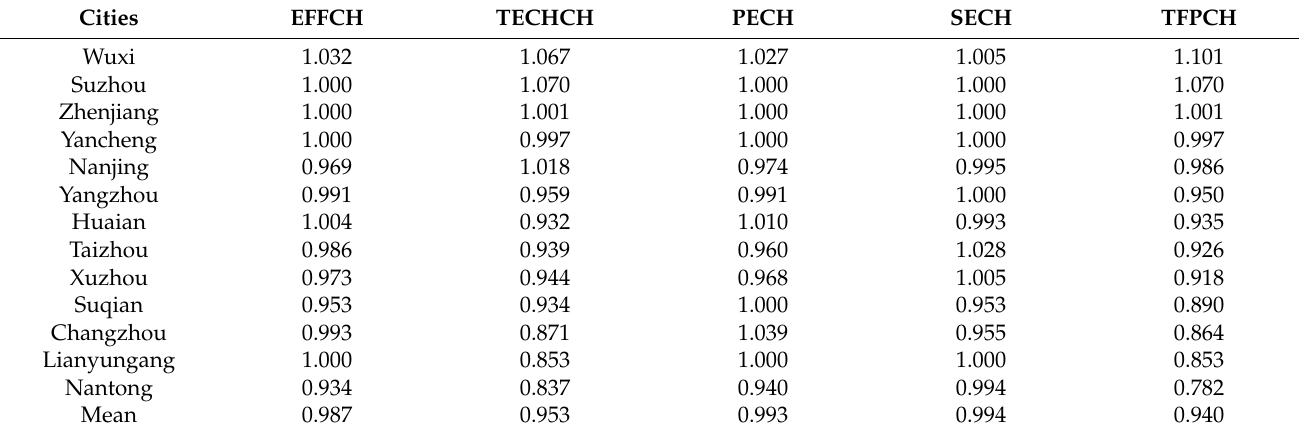
Table 6. Malmquist index of medical and health services in Jiangsu Province and its decomposition during 2015–2019 (geographical